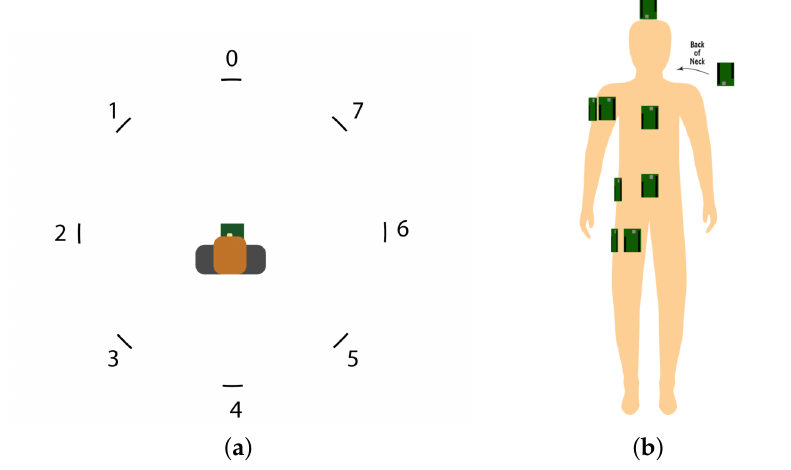
Figure 3. ( a ) Experimental setup with eight fixed anchors and one user equipped with the tag. ( b ) Ultra-wide band (UWB) tag placement on the